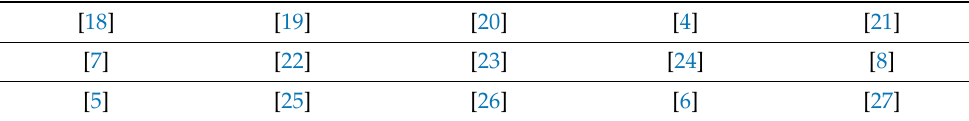
Table 1. Reviewed papers.